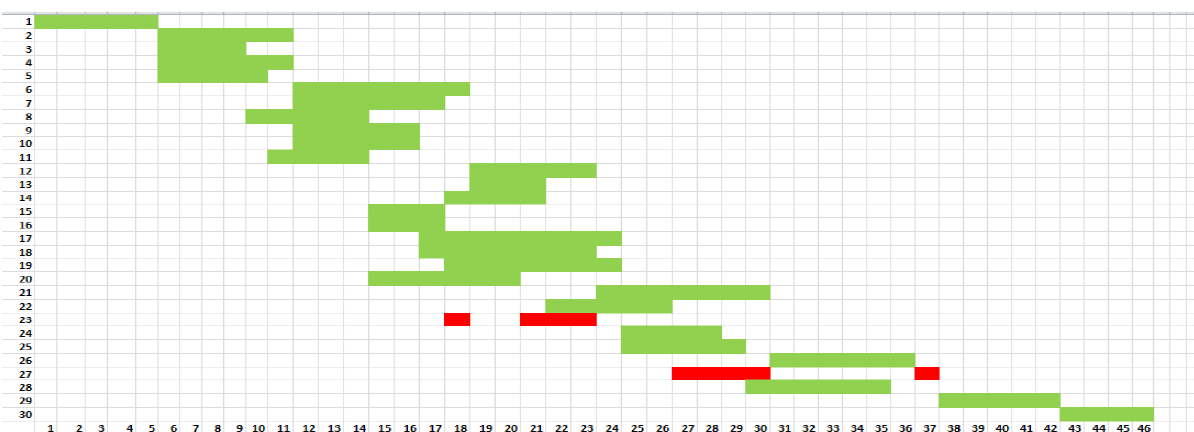
Figure 24. Gantt chart of the 8th experiment after using the proposed method